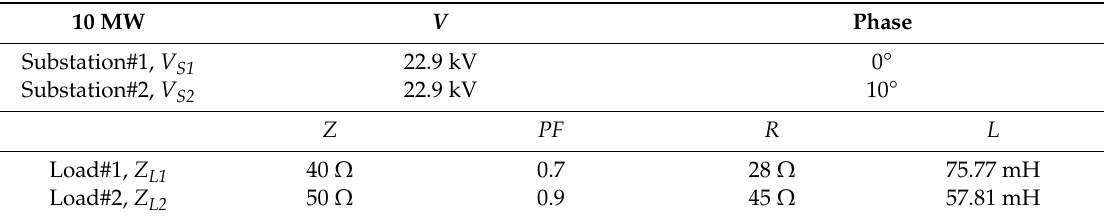
Table 4. Distribution Line Parameters.